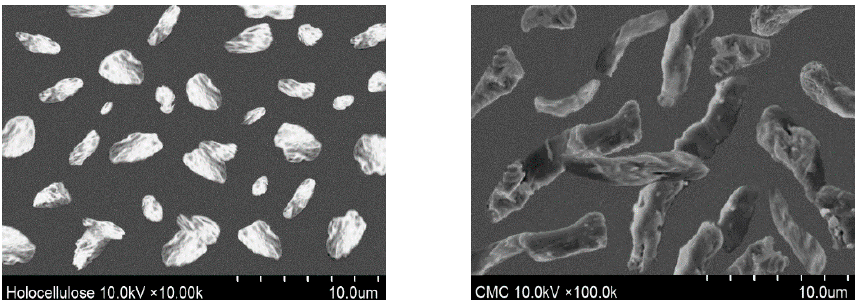
Figure 6. Surface morphology of isolated holocellulose and synthesized CMC ( with DS 1.83) .